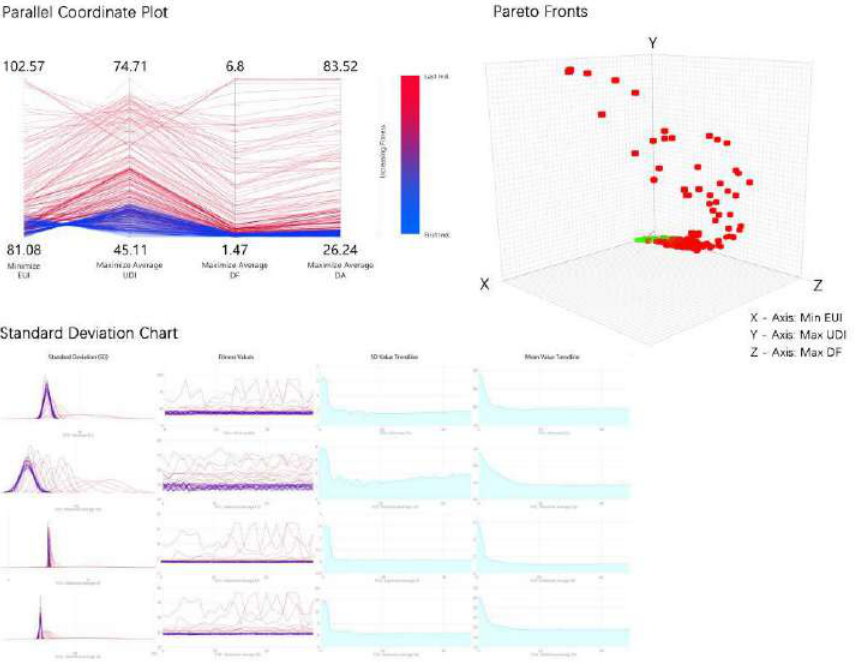
Figure 10. Parallel coordinate plot, Pareto Fronts output, standard deviation, and trendline of each